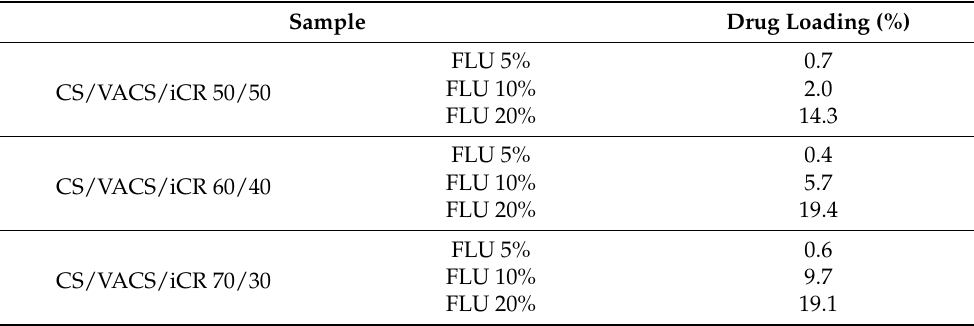
Table 2. FLU loading percentage in CS/VACS/iCR